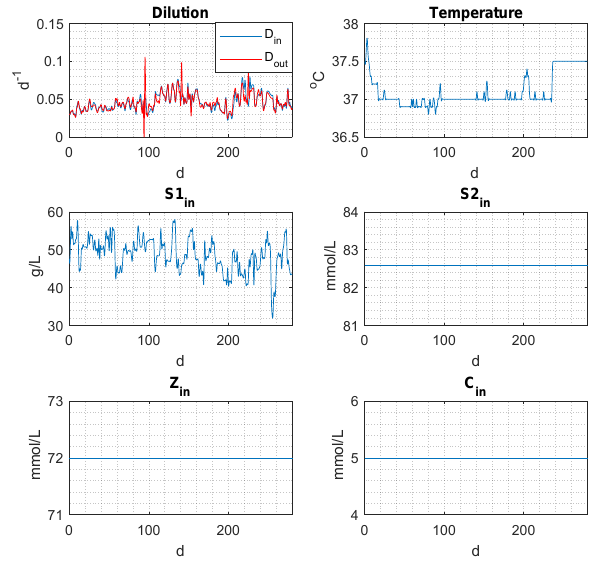
Figure 4: Real inputs used as inputs to the simulation distributed random noise is added to the noise-free sim- ulated measurement. The noise was set to have ampli- tude ± 0.5% of the mean values of the parameter values. For the noise-free case, the parameter estimates are vir- tually equal to the parameter values used in the